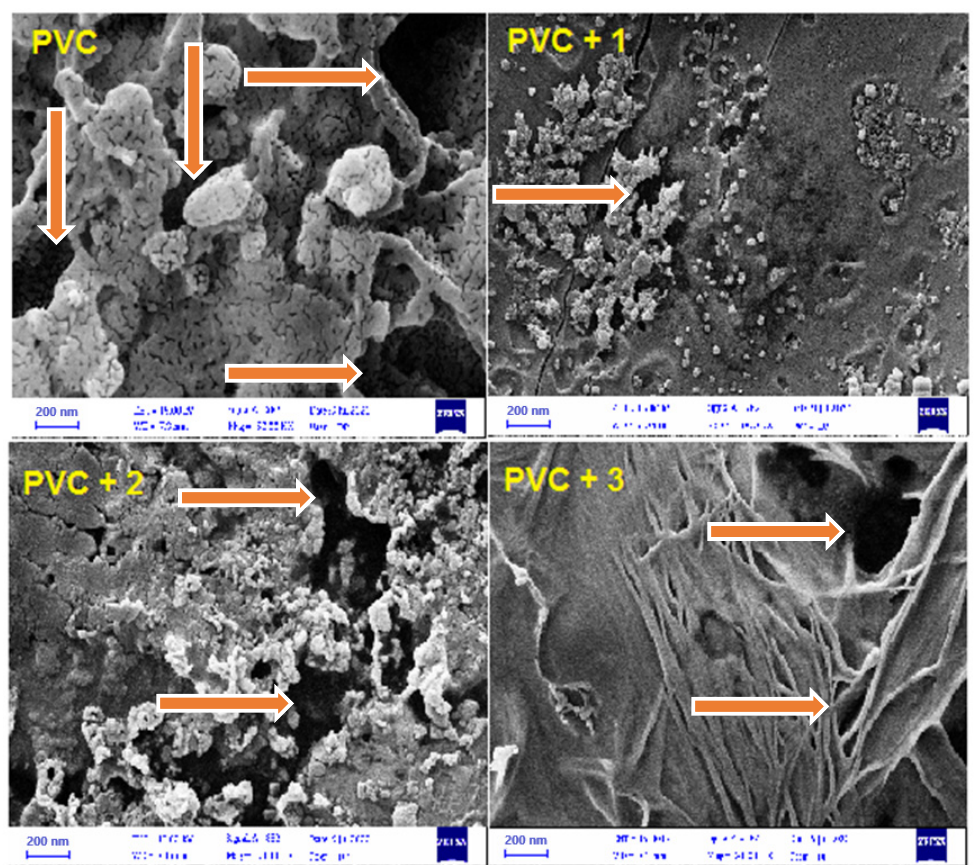
Figure 8. FESEM PVC surface images. ( a ) PVC, ( b ) PVC + 1, ( c ) PVC + 2, and ( d ) PVC + 3 after 300 h of